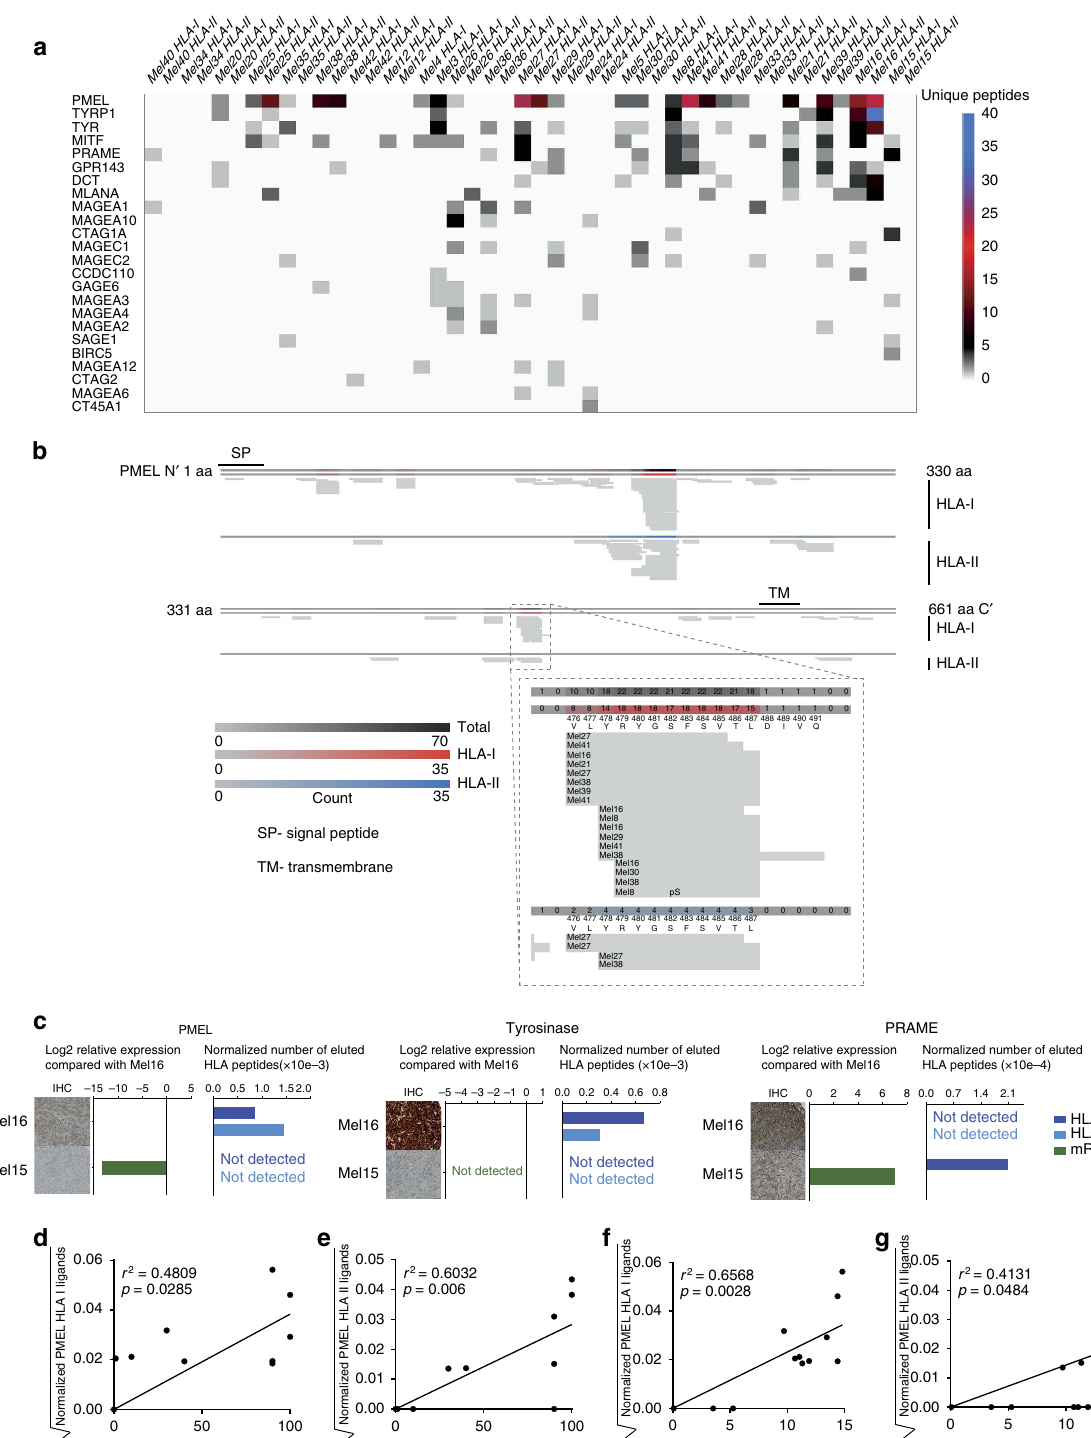
Figure 2 | Presentation of common tumour-associated antigens. Heat map presentation of the number of epitopes per patients that derived from a panel of 24 melanoma antigens ( a ). Alignment of the 99 epitopes from PMEL reveals hot spots presented by several patients in common ( b ). Expression of PMEL, tyrosinase and PRAME on mRNA and protein level is exemplarily compared with the number of HLA ligands for patients Mel15 and Mel16 normalized to the total number of identified HLA ligands. mRNA expression is depicted as log2 relative expression as compared with Mel16. Scale bars of Mel16-PMEL, Mel15-Tyrosinase, Mel15- and Mel16-PRAME: 50 m m; scale bars of Mel15-PMEL, Mel16-Tyrosinase: 100 m m ( c ). The number of PMEL-derived HLA class I or II ligands identified by immunopeptidomics was normalized to the total number of identified HLA ligands in the respective patient sample. Square root transformation was applied to deal with deviations from a normal distribution ( c ). Normalized HLA ligand numbers of PMEL of 12 patients with 4 2000 HLA I ligands are plotted against per cent positive cells per tissue section as determined by IHC ( d , e ) or against log2 fold mRNA expression relative to a tissue panel consisting of 20 human tissues ( f , g ). Pearson correlation was calculated and the respective p value was corrected for multiple testing. For visual guidance a regression line is depicted on each